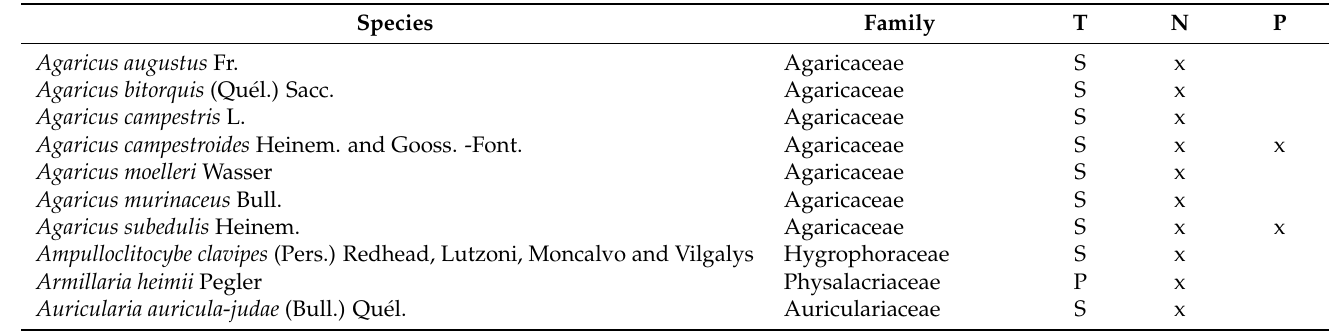
Table 2. List of wild edible fungal species collected from study sites in natural and plantation forests,